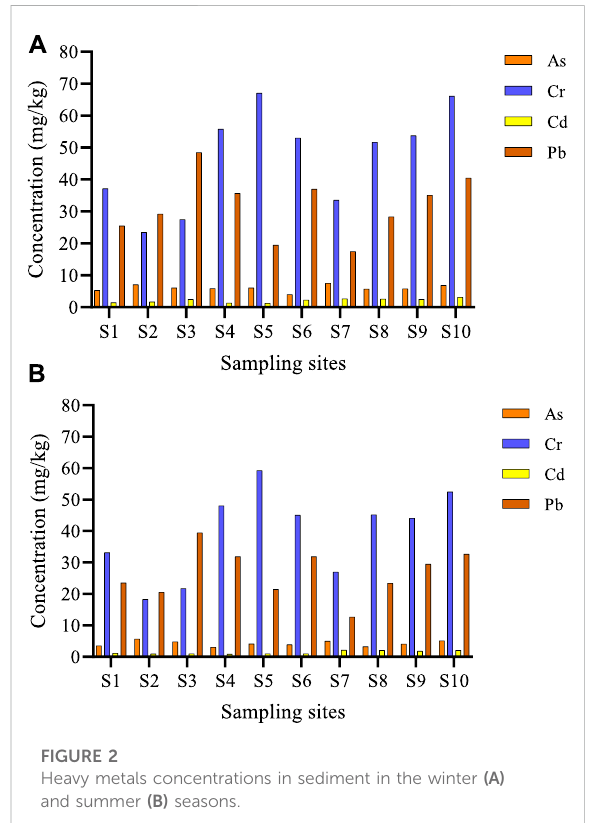
FIGURE 2 Heavy metals concentrations in sediment in the winter (A) and summer (B)